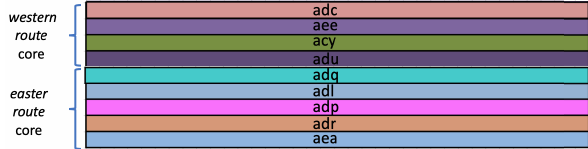
Figure 7. Sectorization of Barcelona control center (Instance 1).